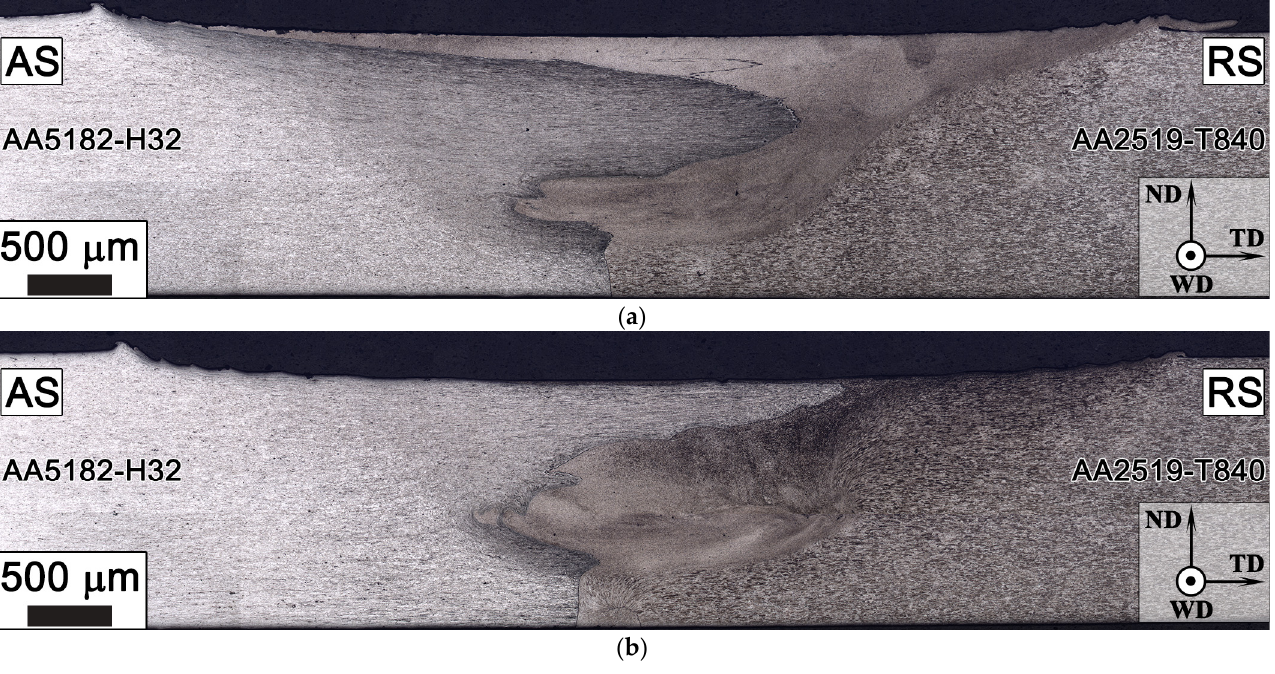
Figure 3. Optical micrographs of 500@15 ( a ) and 1100@30 ( b ) and welds. ND, TD, and WD represent the normal direction, transverse direction, and welding direction, respectively.